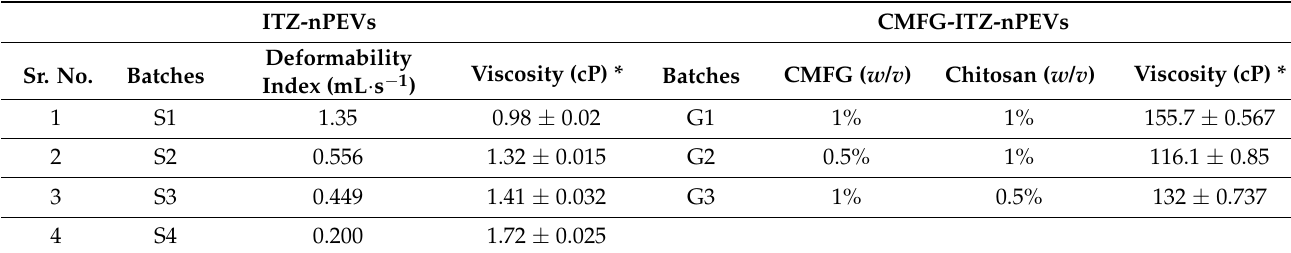
Table 2. Deformability index and viscosity of ITZ-nPEVs and CMFG-ITZ-nPEVs formulations. ITZ-nPEVs CMFG-ITZ-nPEVs